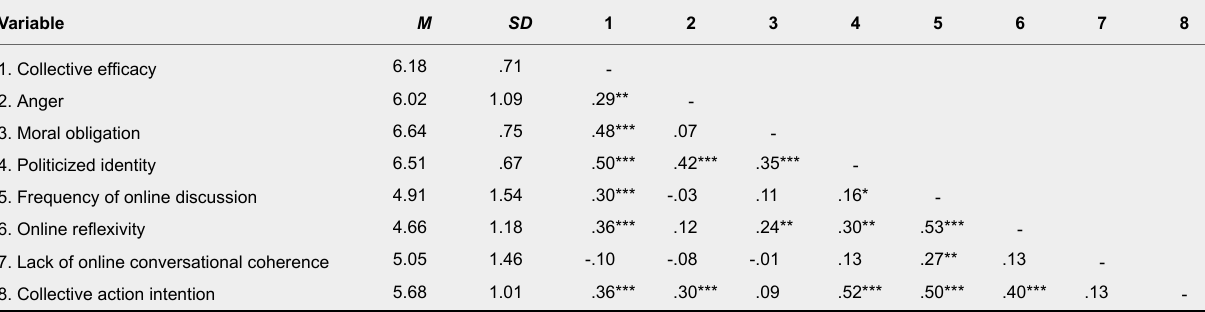
Descriptive Statistics and